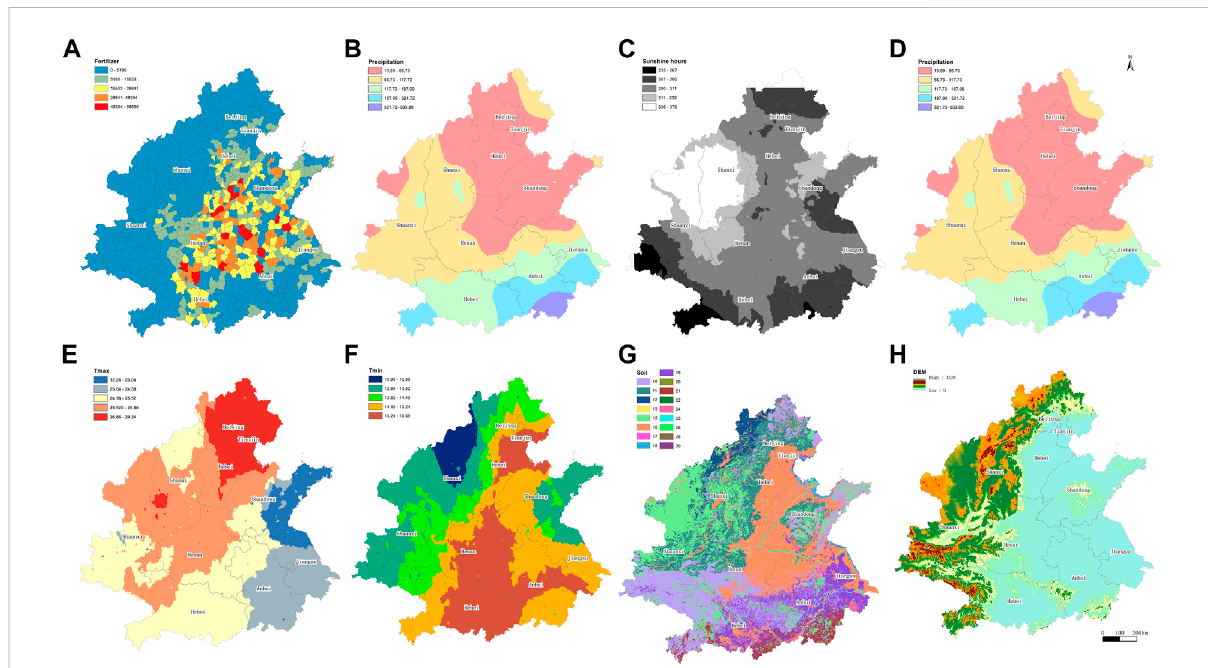
FIGURE 2 Distribution of the in fl uencing factors. (A) Fertilizer, (B) irrigation, (C) sunshine, (D) precipitation, (E) maximum temperature, (F) minimum temperature, (G) soiltype,and (H) terrain.Soiltypelegendsareexplainedasfollows:10,leachingsoil;11,semi-leachingsoil;12,calciumlayersoil;13, dry soil; 15, primary soil; 16, semi-hydrated soil; 17, hydrated soil; 18, saline-alkali soil; 19, arti fi cial soil; 20, alpine soil; 21, ferrallite; 22, urban district; 24, lakes and reservoirs; 25, rivers; 26, sandbars and islands in rivers; 28, coral reefs and sea island; and 30, coastal salt